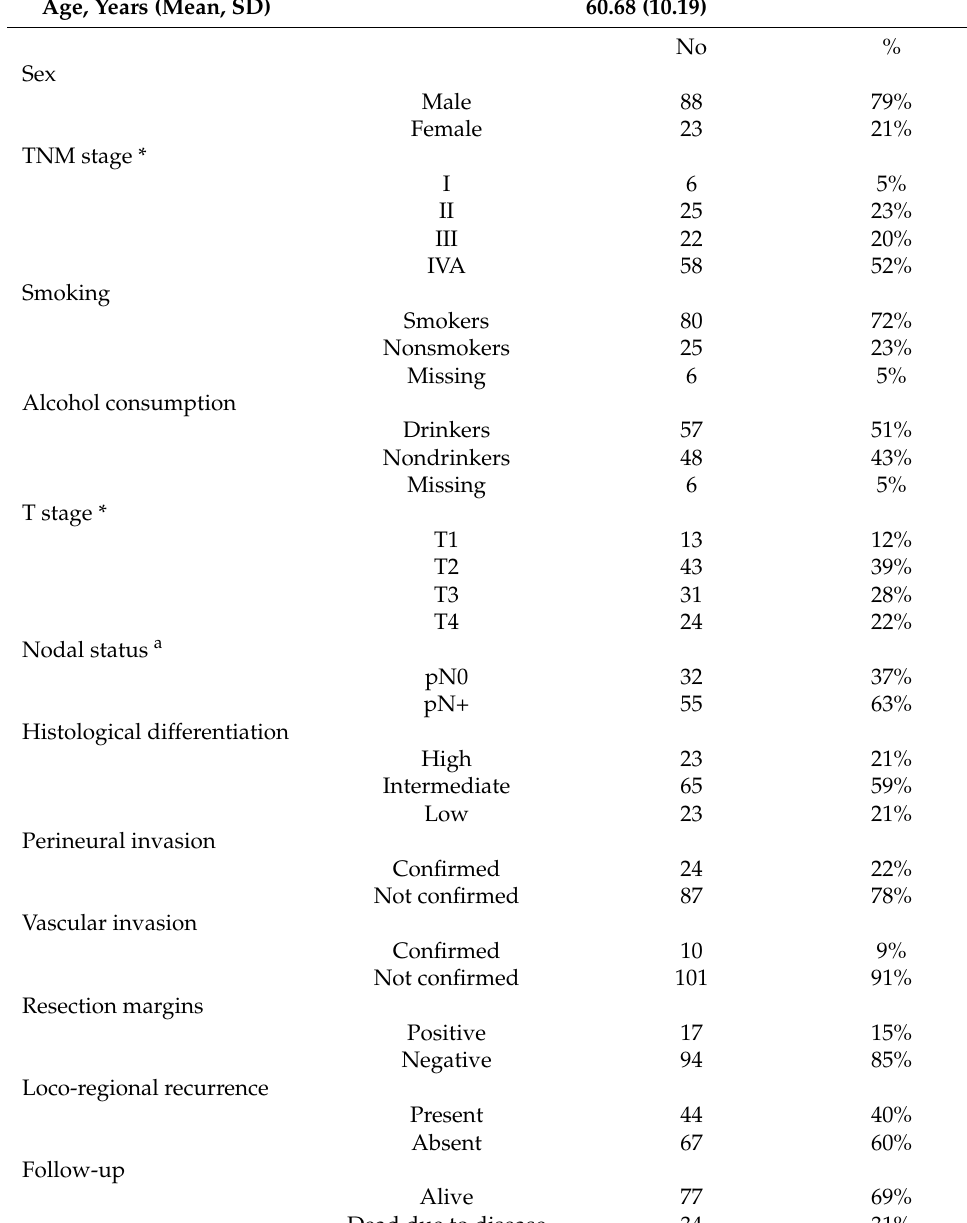
Table 1. Descriptive statistics in OSCC.